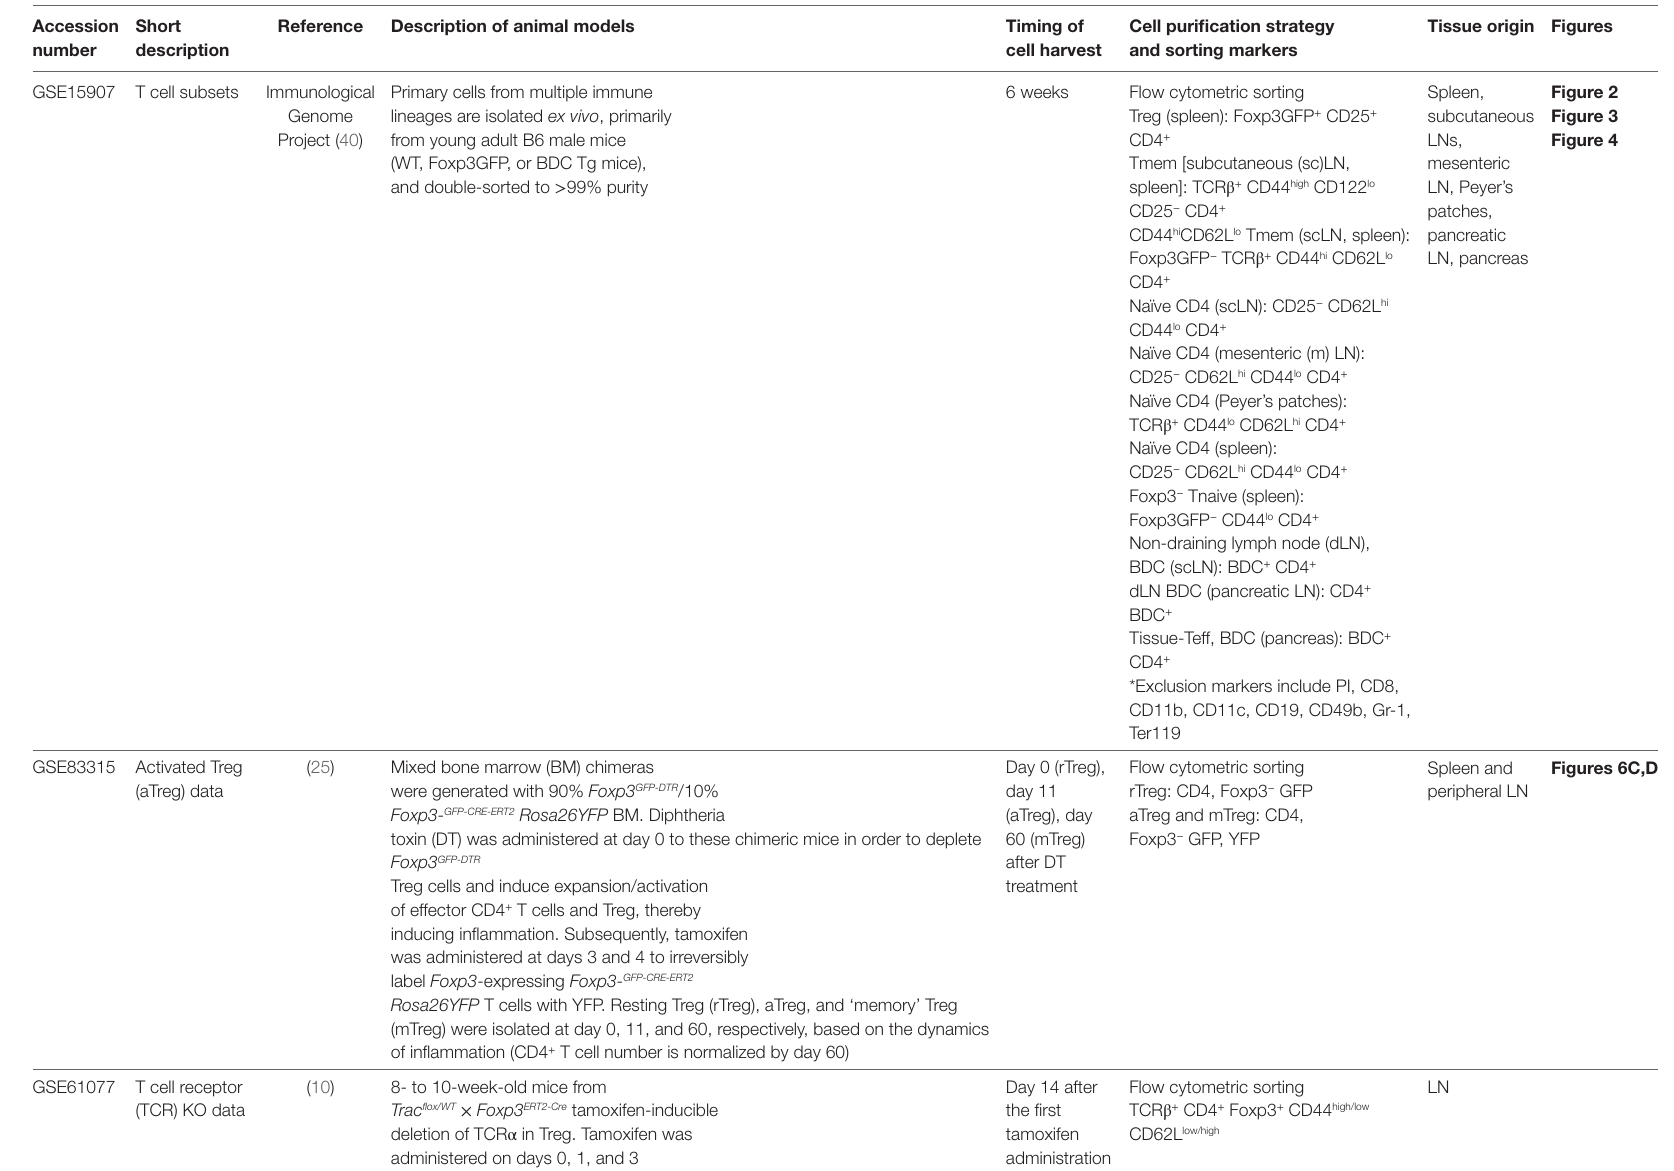
TaBle 1 | Datasets used in this